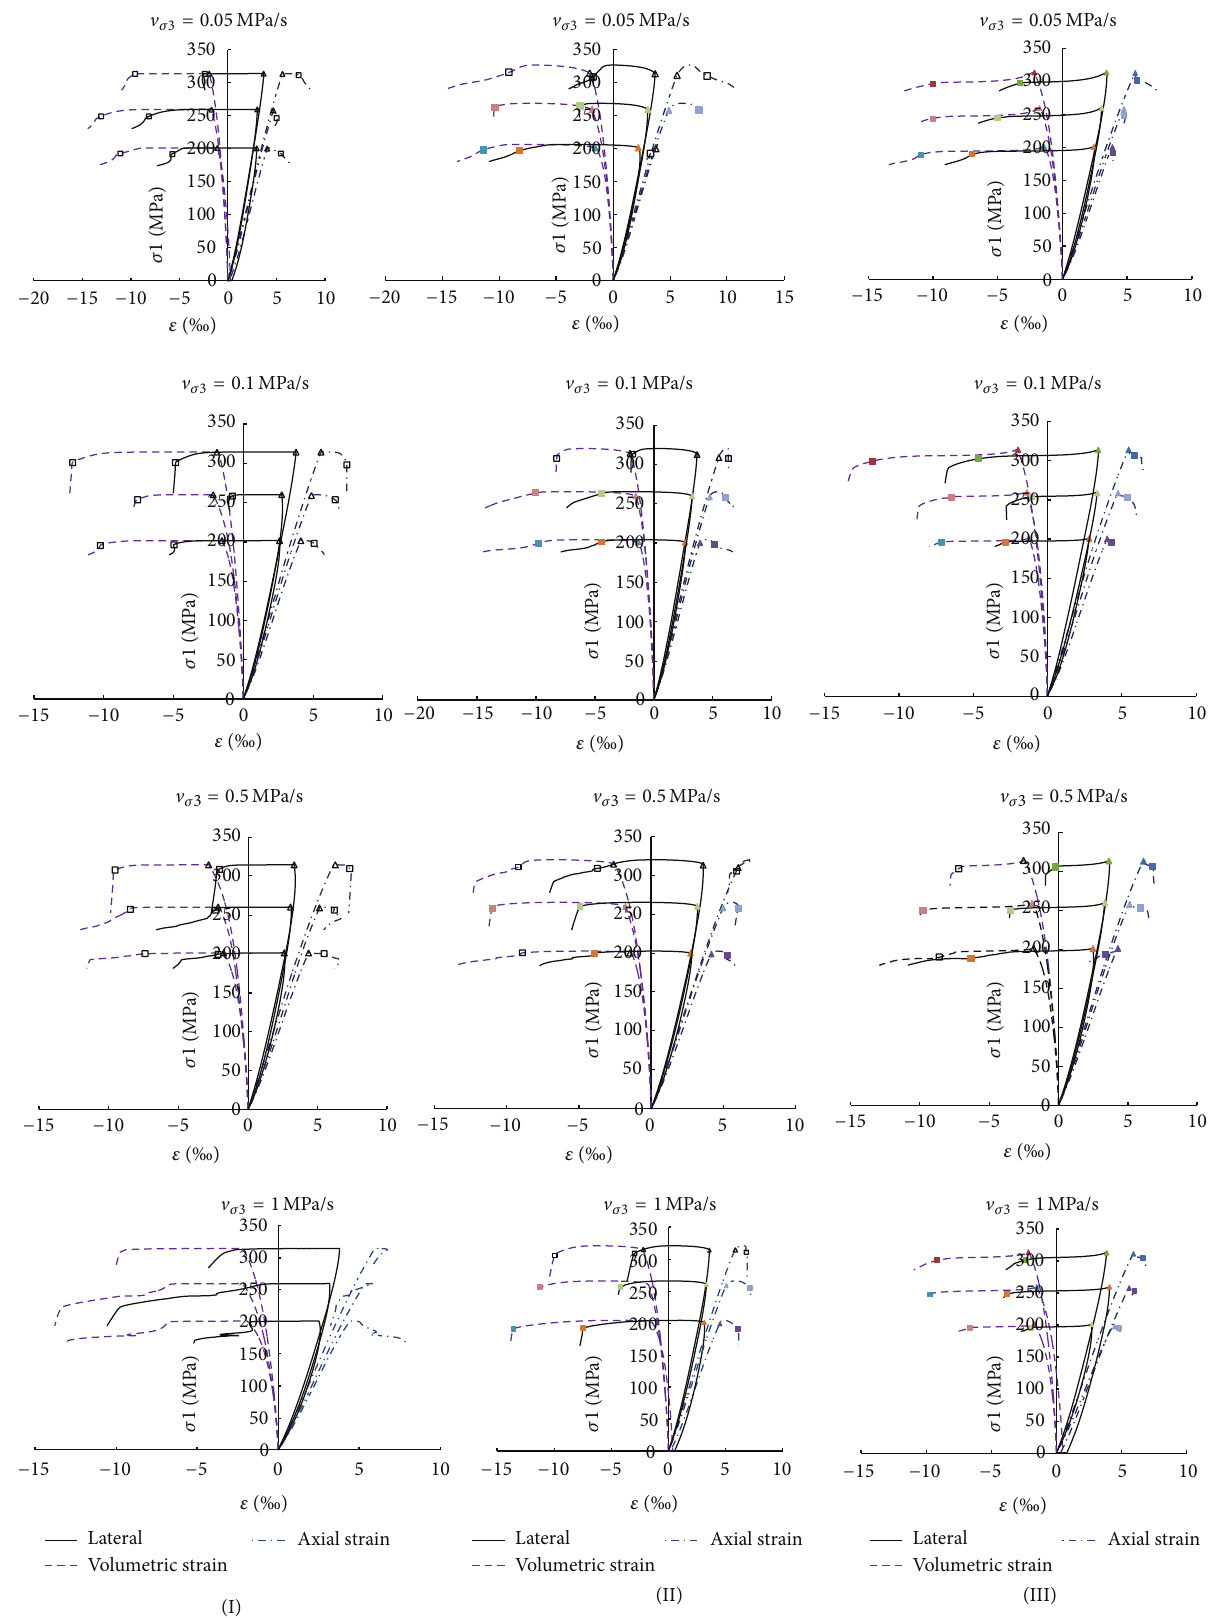
Figure 1: Complete stress-strain curves of rock under different paths and unloading rates of confining